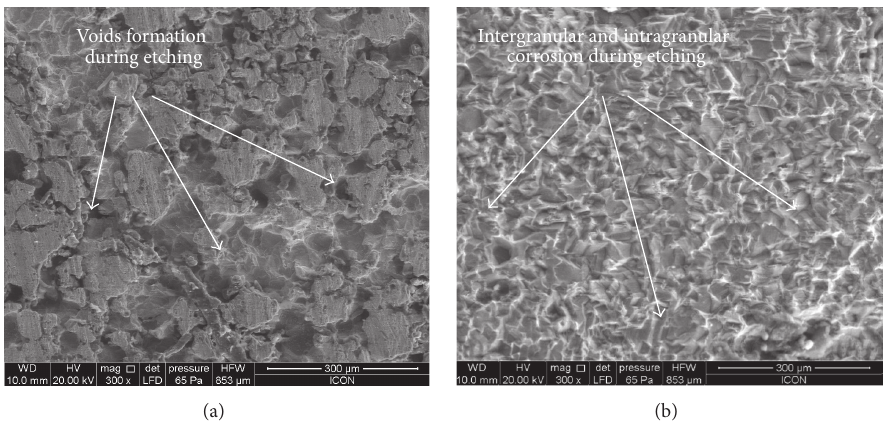
Figure 14: SEM image for a specimen photochemically machined at (a) 45 ∘ C and (b) 55 ∘